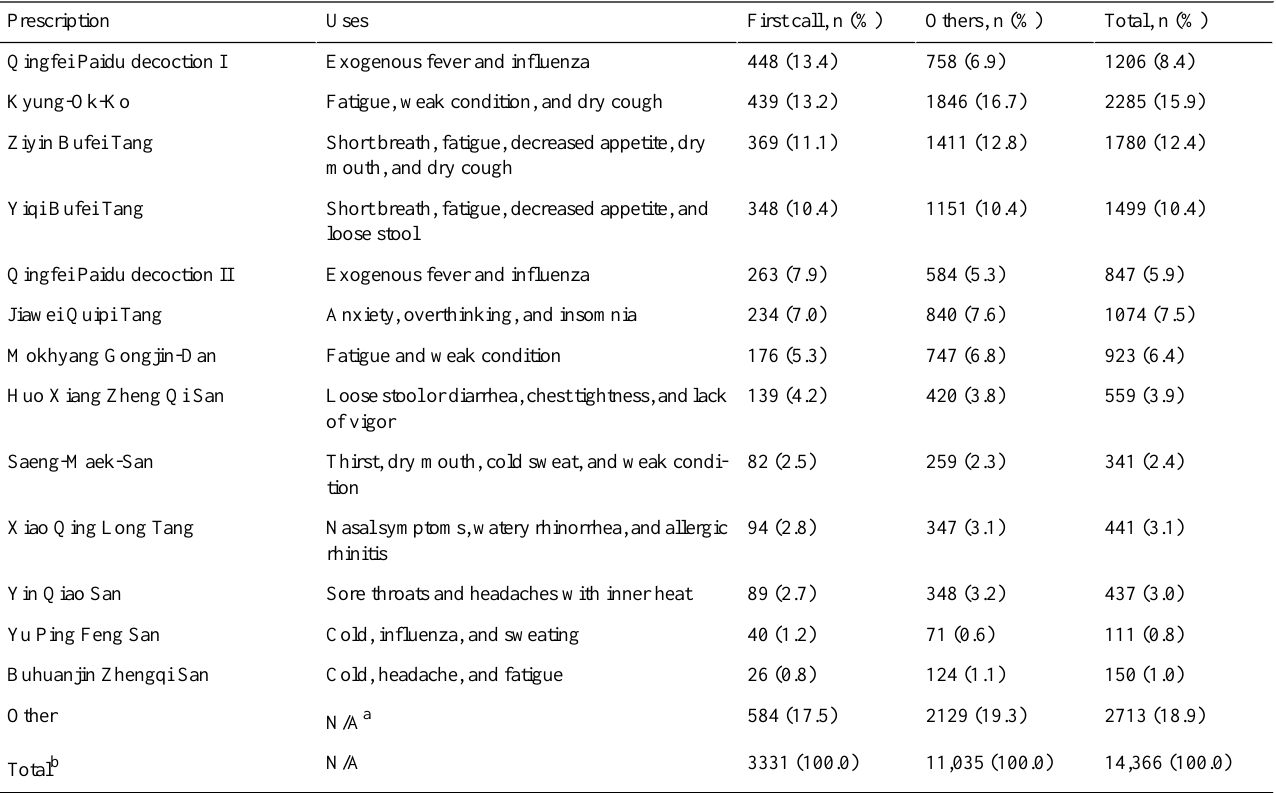
Table 2. Frequency of prescriptions by the Korean Medicine telemedicine program for